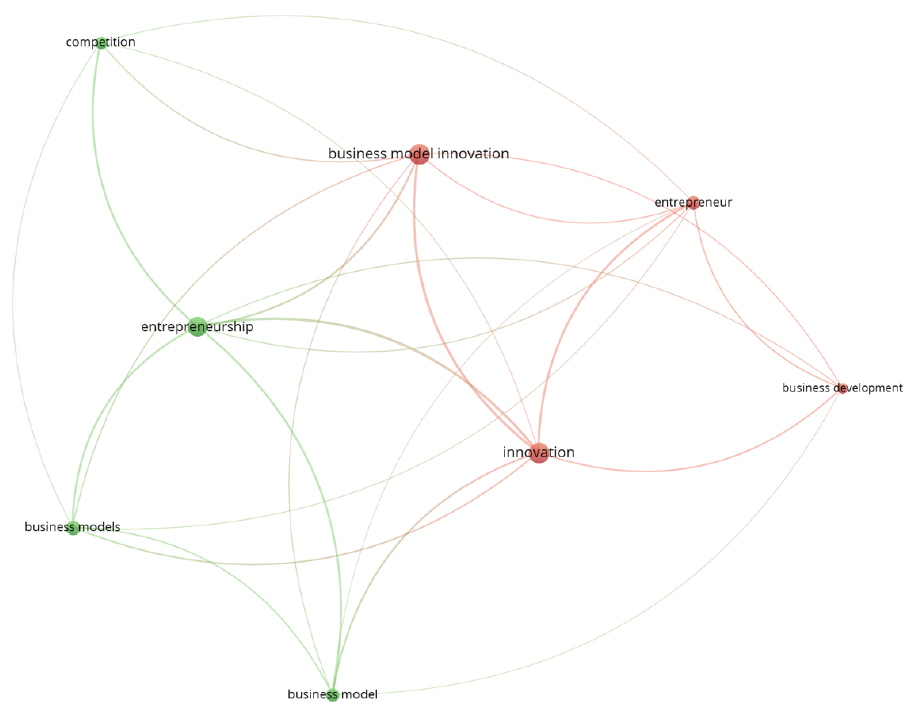
Fig. 5. The new map of